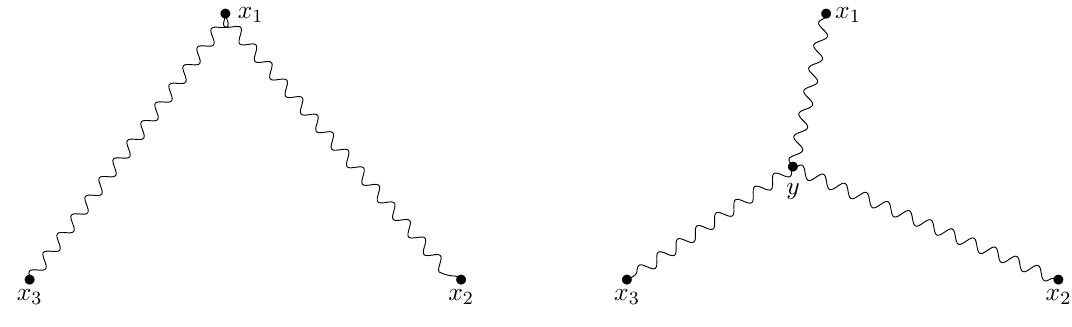
Figure 2. Simplest Feynman diagrams contributing to the connected part of